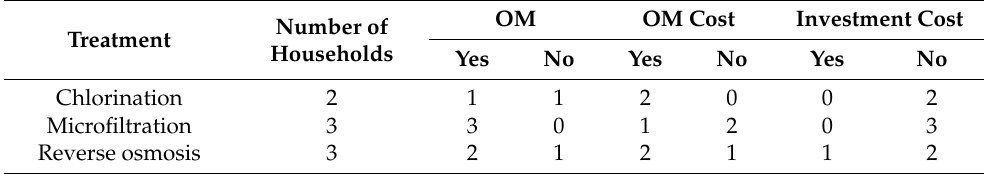
Table 5. Household acceptance of operation and maintenance, operation and maintenance cost, and investment cost for each treatment system (yes: acceptable; no: not acceptable). OM OM Cost Investment Cost Number of Treatment Households Yes Chlorination